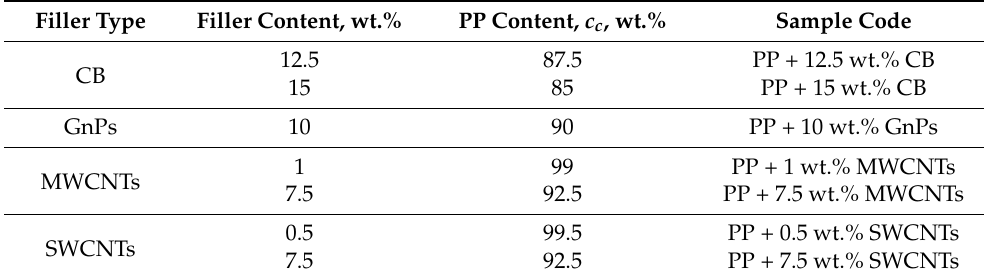
Table 1. The formulation of composites.